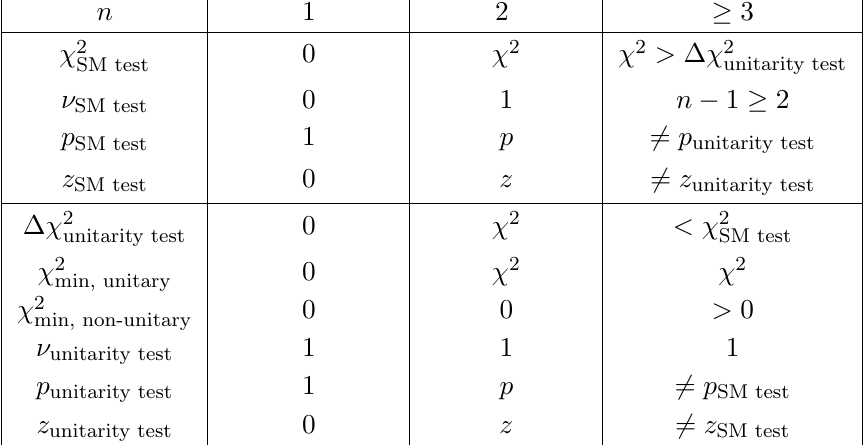
Table 1 . General comparison of the Cabibbo angle universality SM test and the CKM unitarity test, showing that the test results are di(cid:11)erent starting from three observables. For the goodness-of-(cid:12)t test we